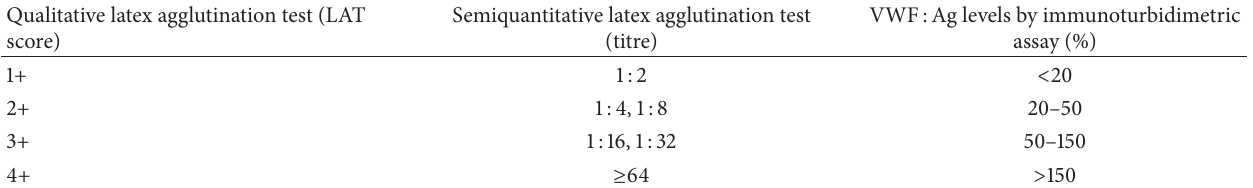
Table 7: Correlation of result interpretations by latex agglutination test and immunoturbidimetric assay. Qualitative latex agglutination test